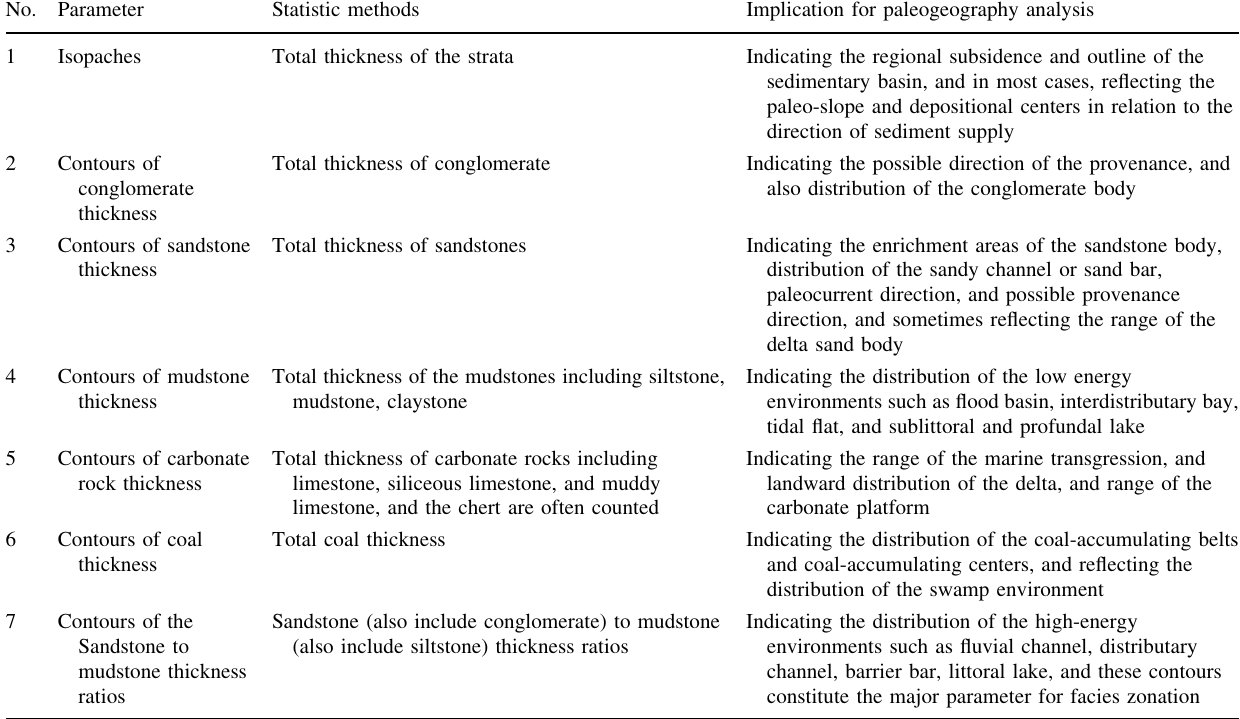
Table 1 Lithological parameters of the contour maps for the reconstruction of paleogeography No.